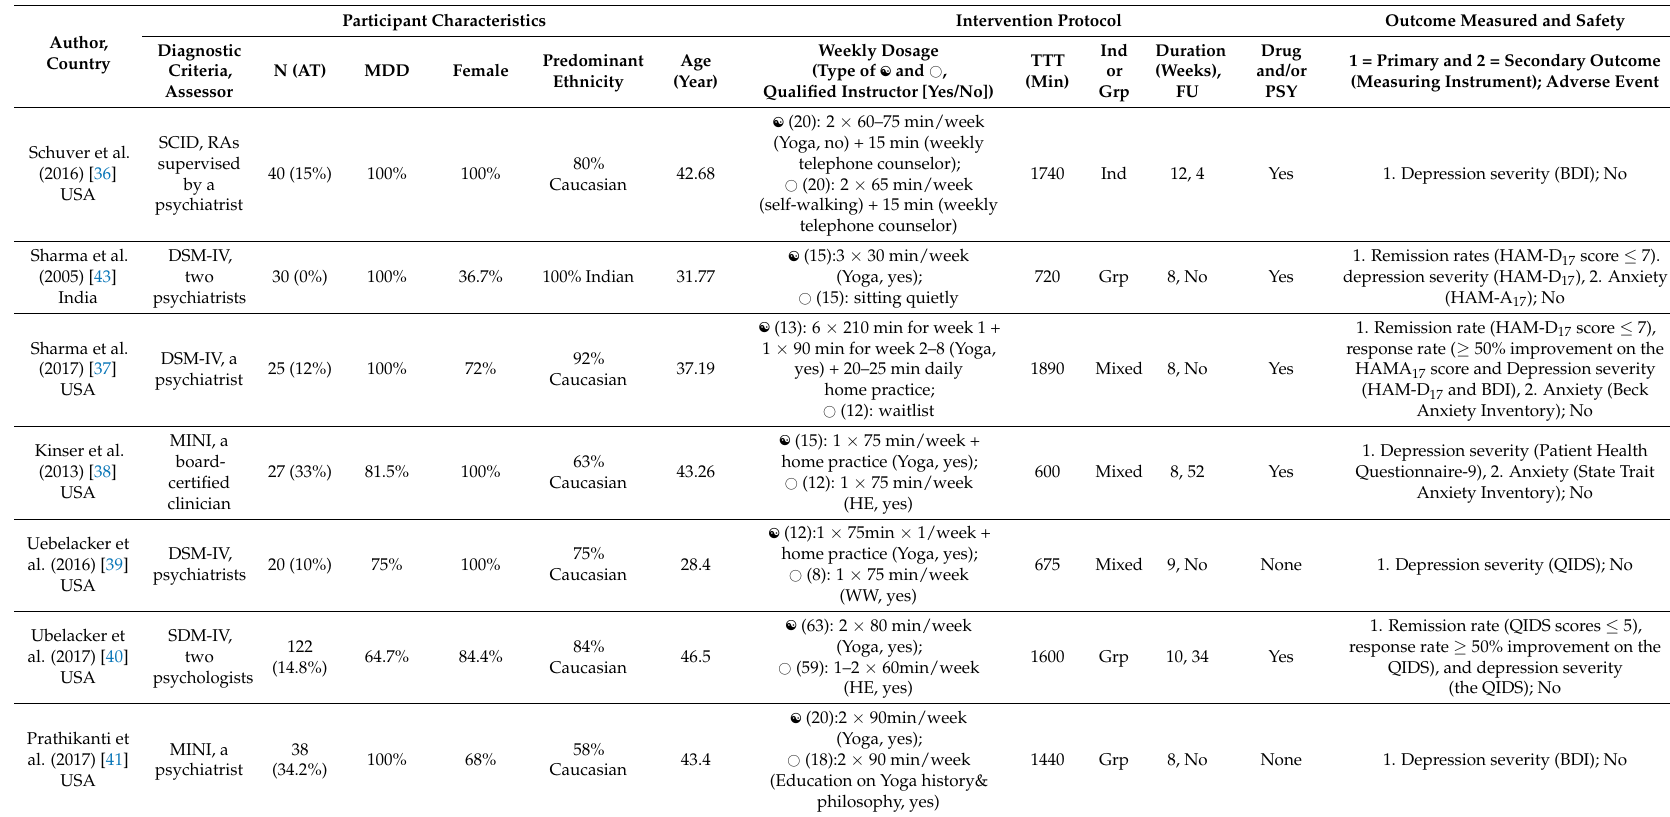
Table 1. Characteristics of all randomized controlled trials.